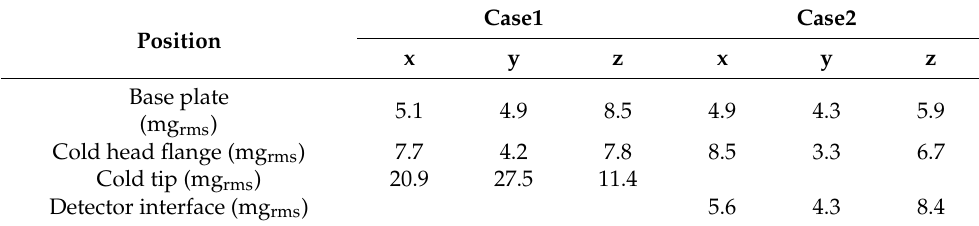
Figure 8. Detector interface vibration isolation performance. Table 4. Heat links isolation performance measurement results